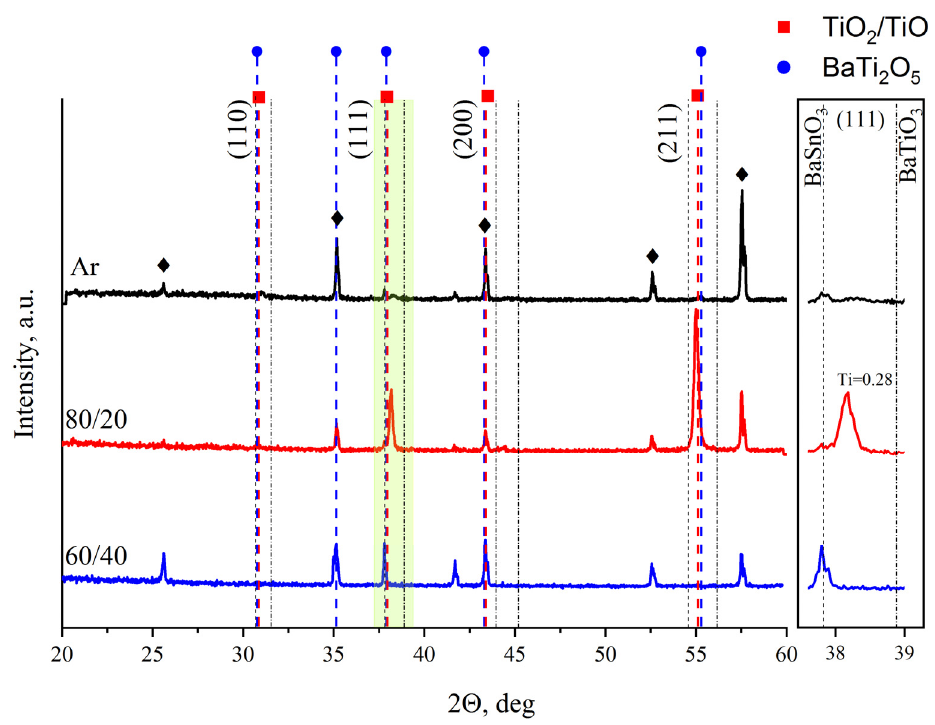
Figure 1. Diffractograms of the BTS thin films on Al 2 O 3 substrates deposited at different oxygen concentrations in gas ambient.